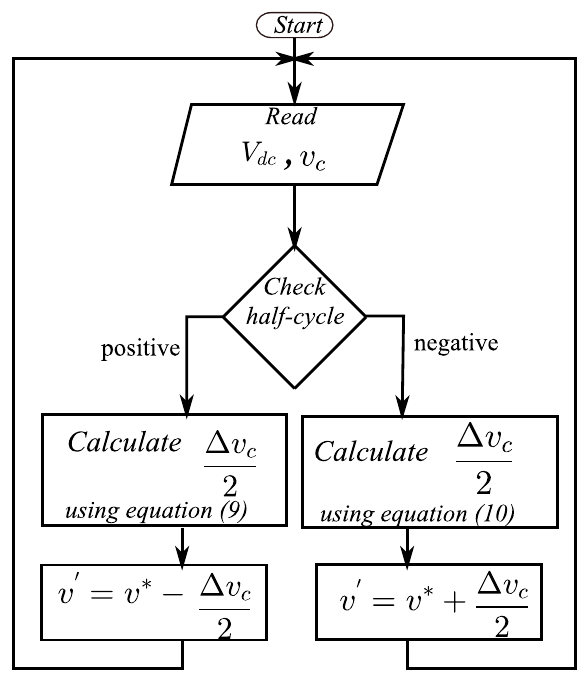
Figure 7. Modification of the reference